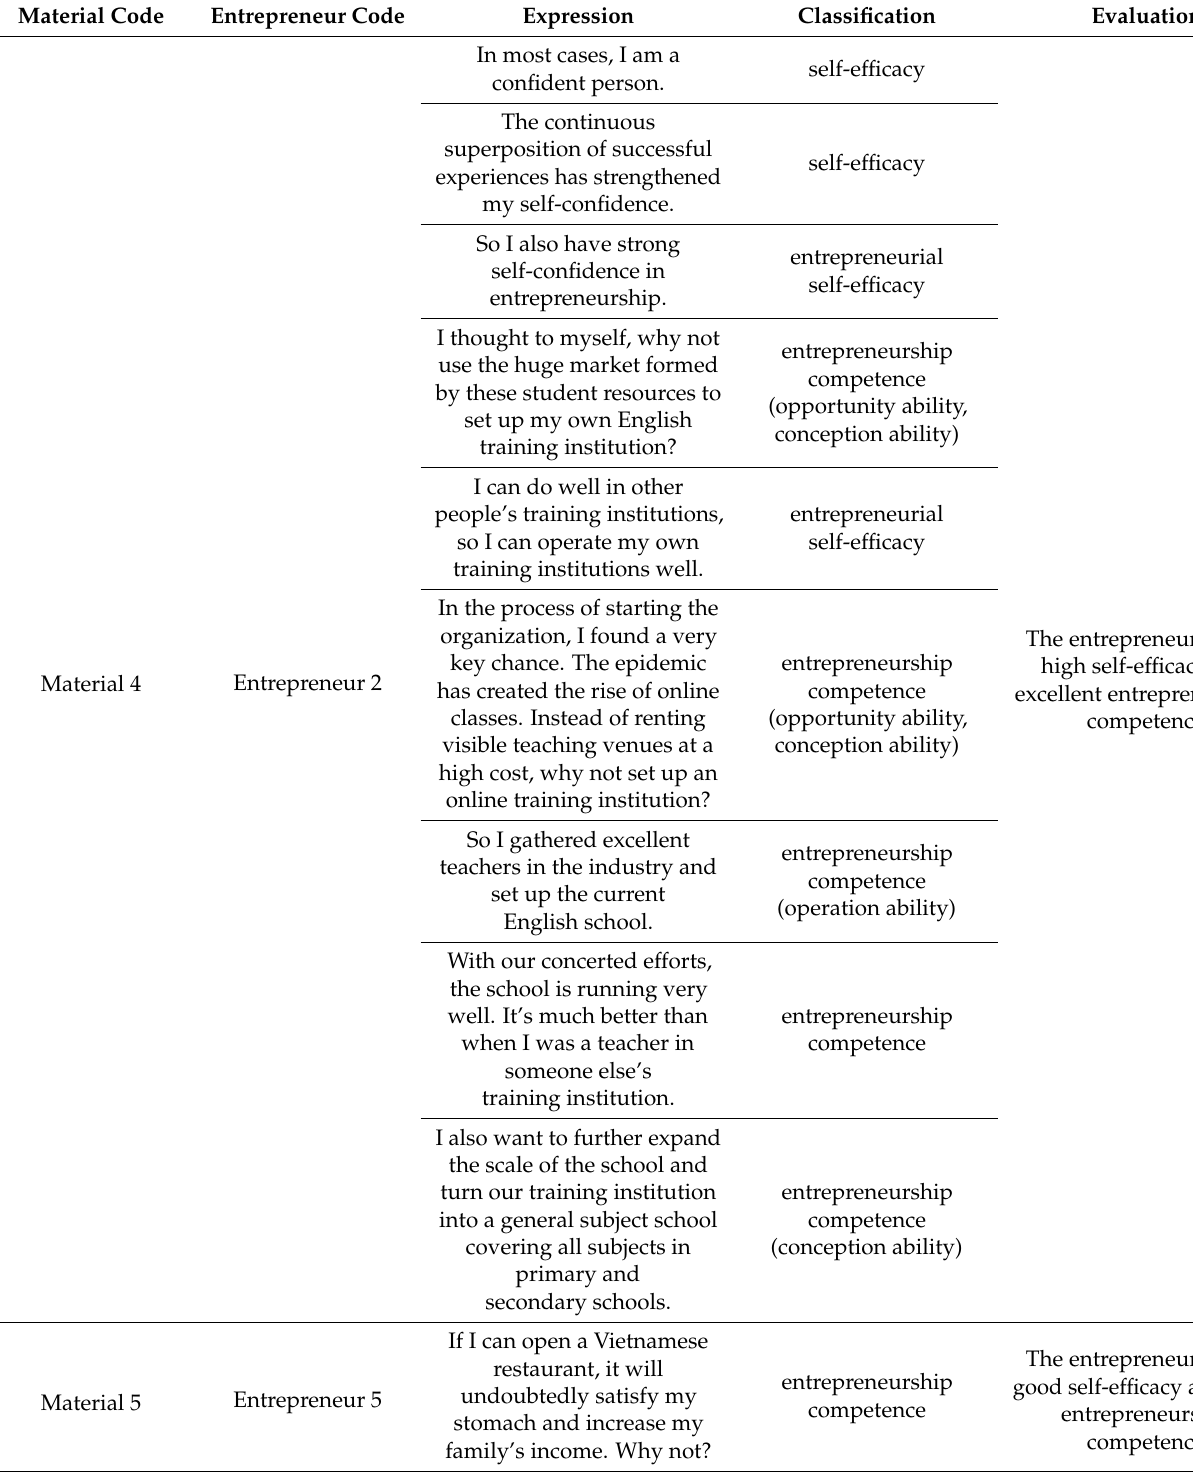
Table 2. Interview material distilling